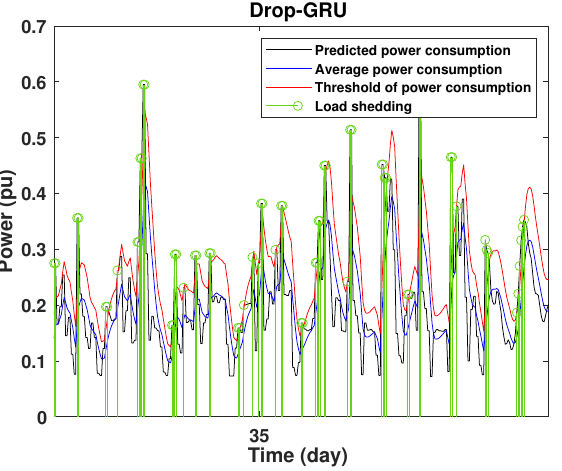
Figure 25. Detection of power consumption peaks during 3 days using the Drop-GRU model. As shown from these figures, the three models are able to predict the peaks of the power consumption with a very low shift of time compared to the real time. The